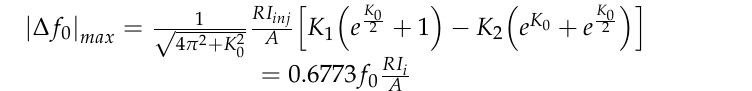
Figure 3. Pulse generator chronogram . To create sufficient pulses to operate the synchronization by injection, a delay of 𝑡 (cid:3029)(cid:3036)(cid:3047) 2⁄ is added in one of the two paths. Then, both of these paths constitute the two inputs of an XOR gate. The output of this generates the resultant voltage pulses and, as shown in Figure 1, is connected to the next sub-element: the V/I converter. 3.2. Voltage-to-Current Converter In order to operate a correct injection-locking process, these voltage pulses need to be converted into current ones. This is the goal of the V/I converter described here and shown in Figure 4. Figure 4. V/I converter schematic. The output of this element is then directly connected to the ring oscillator to effec- tively achieve synchronization by injection. The conversion is handled by the Nmos and Pmos output transistors and is connected to the first stage of the ring oscillator. An addi- tional input ( V ctrl inj ) is added to tune the applied injection strength. 3.3. Ring Oscillator The ring oscillator is composed of three stages of differential inverters. The main as- set of the differential mode compared to the single mode comes from its better rejection noise stemming from the substrate and power supply.